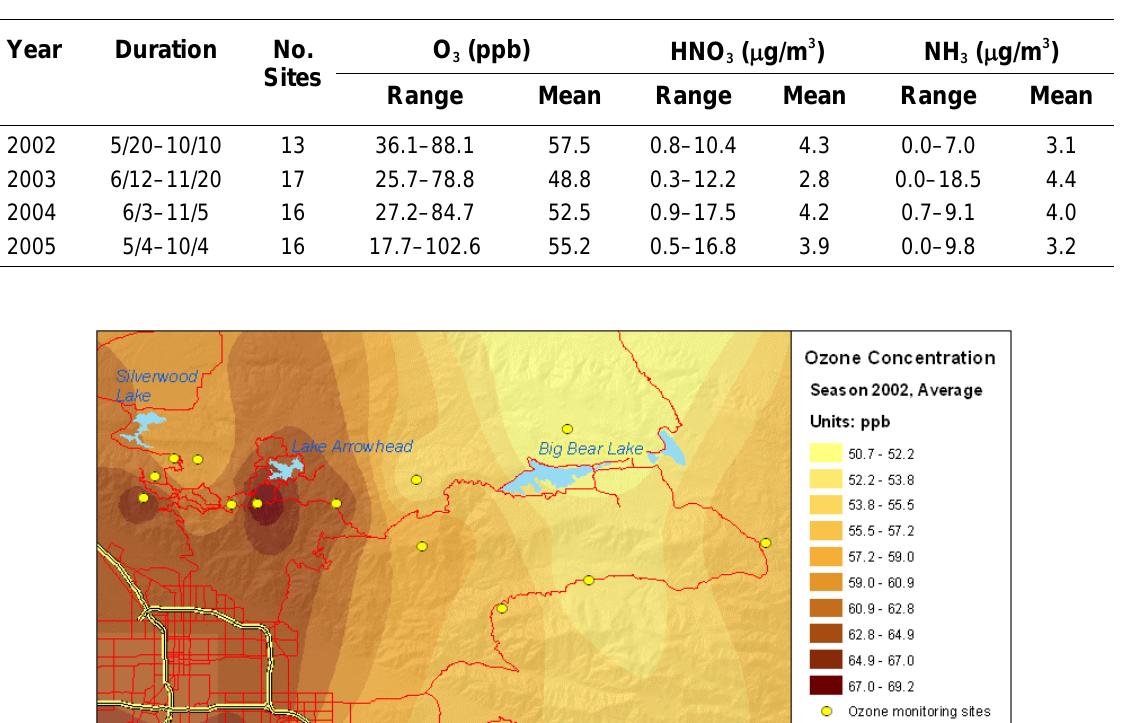
Summary of Air Pollution Monitoring for the SBM Network, Based on 2-Week Long Collection